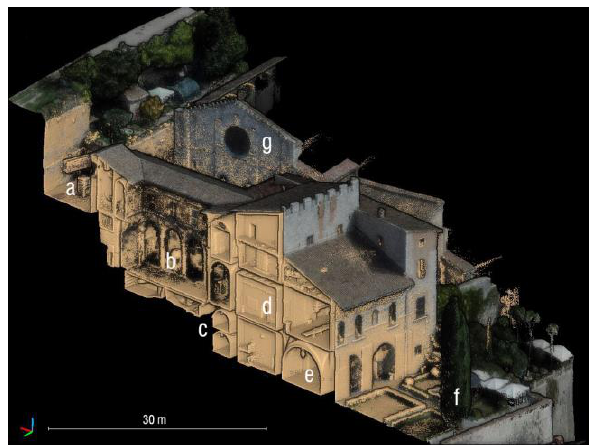
Figure 1. Composition of the complex of “Palazzo Ducale”: (a) “Palazzo Vecchio”, (b) courtyard, (c) double level of underground, (d) main floor and upper levels, (e) passage of the street, (f) garden, (g) façade of the Cathedral facing the main entrance of the palace.